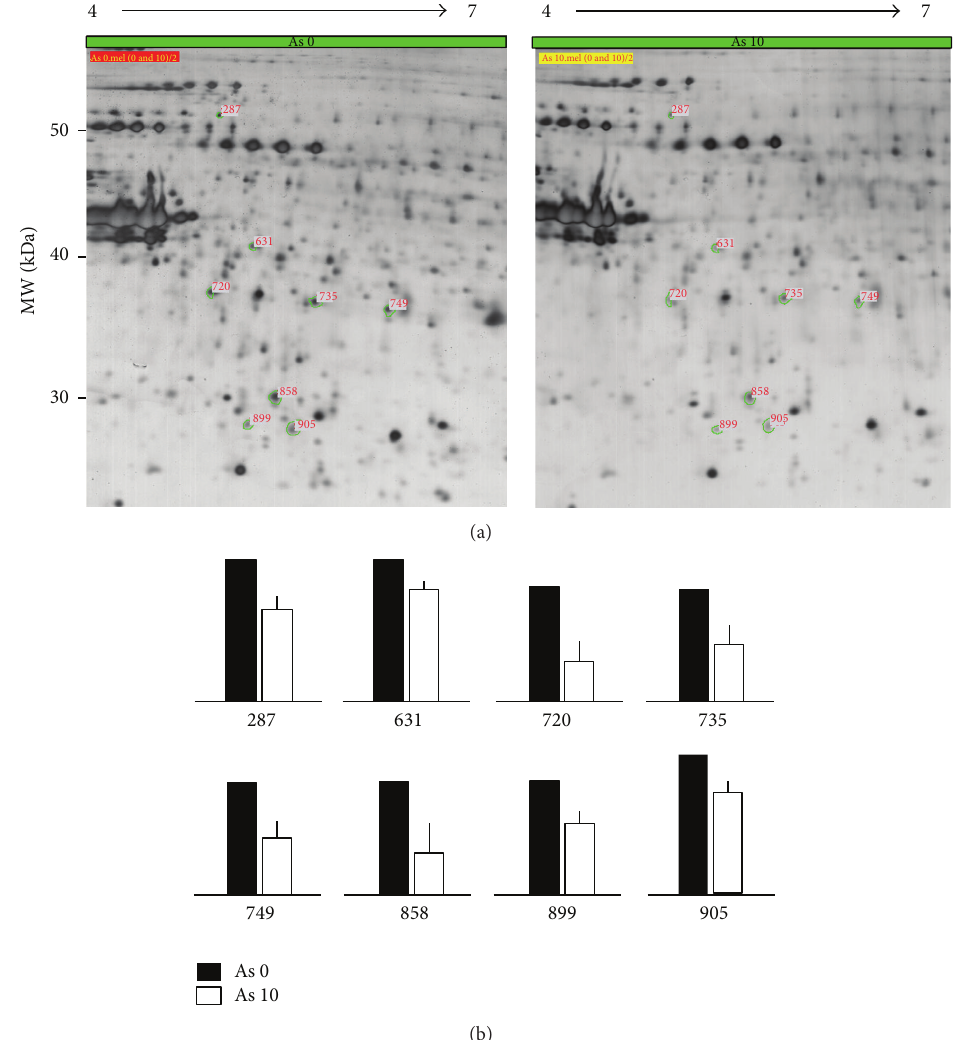
Figure 3: Translational proteome regulated by arsenic. The cell lysates (1mg) treated with 10 𝜇 M of arsenic for 1 h were separated by 2-DE (pH4–7). By using ImageMaster software, the proteins with decreased expression ( < 0.7 fold) were indicated. (b) The relative expression levels of these decreased proteins were statistically calculated from three